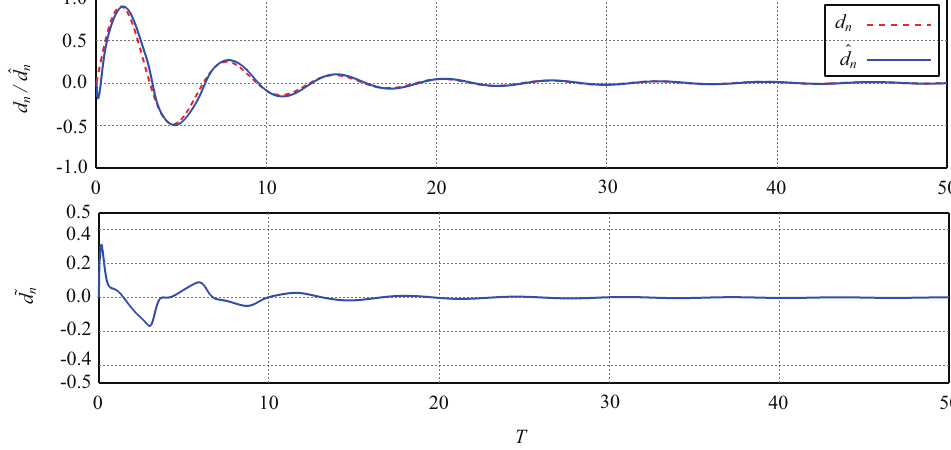
Figure 9. Estimation performance of LESO to the disturbance in Case